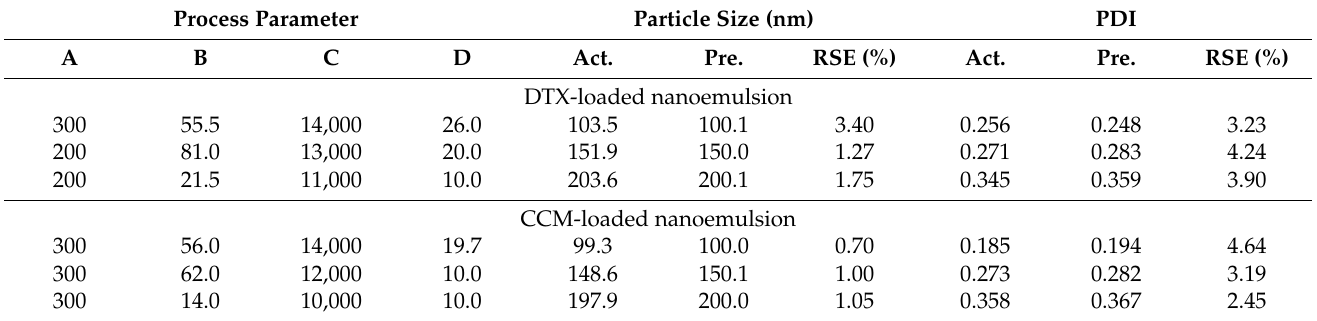
Table 3. Response values for validation of DTX- and CCM-loaded nanoemulsion models.